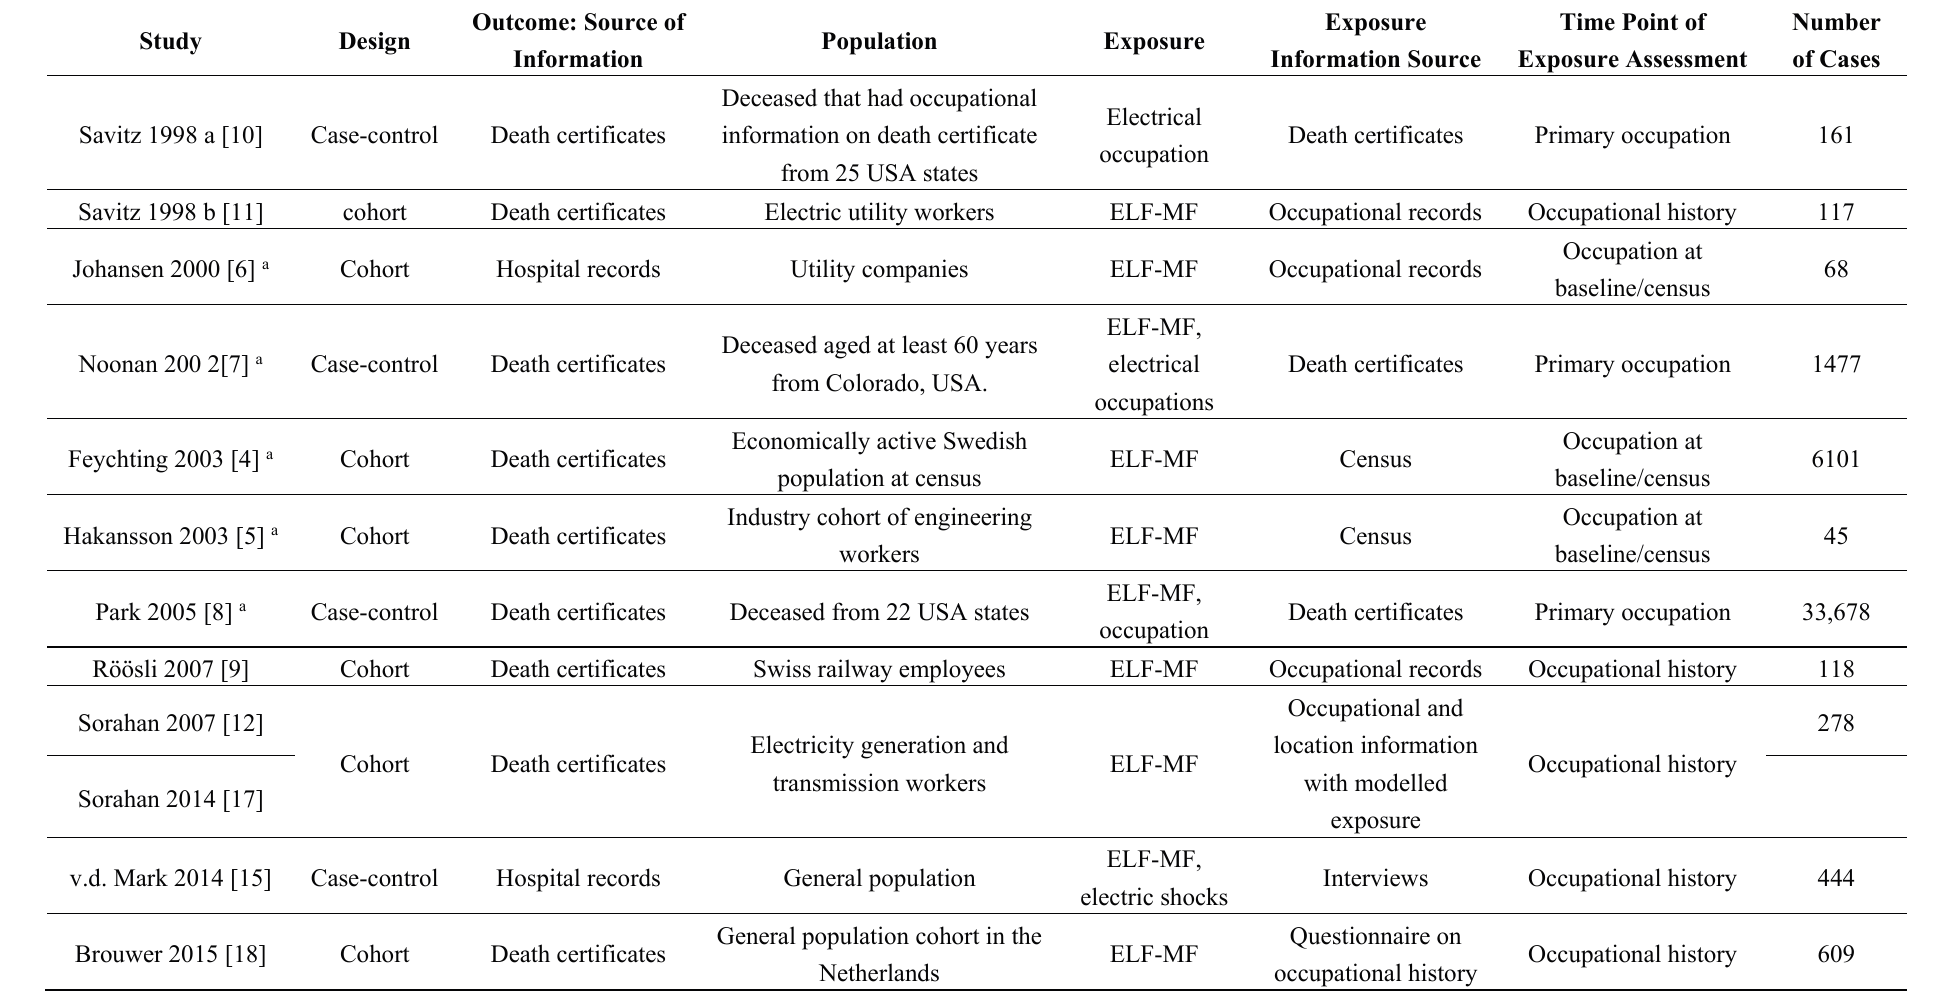
Table 1. Characteristics of studies of occupational ELF-MF exposure and Parkinson’s